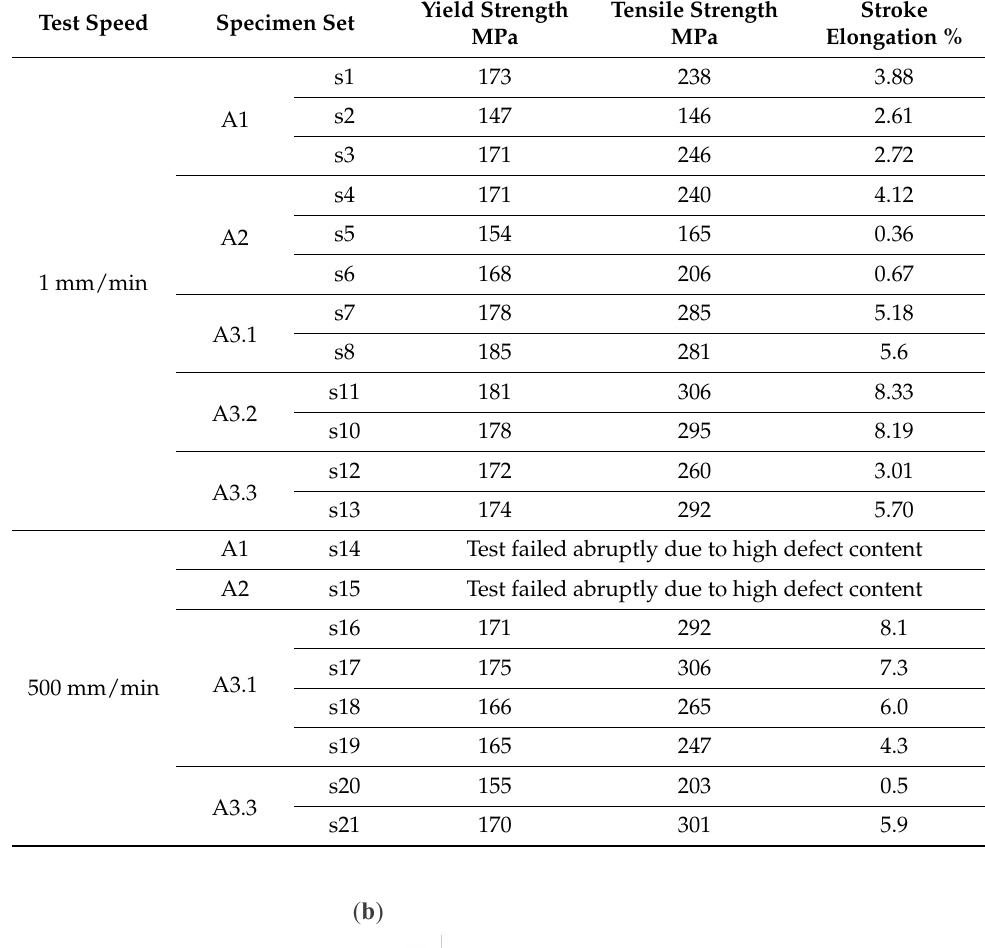
Table 6. Tensile Test Results of Alloy Sets.